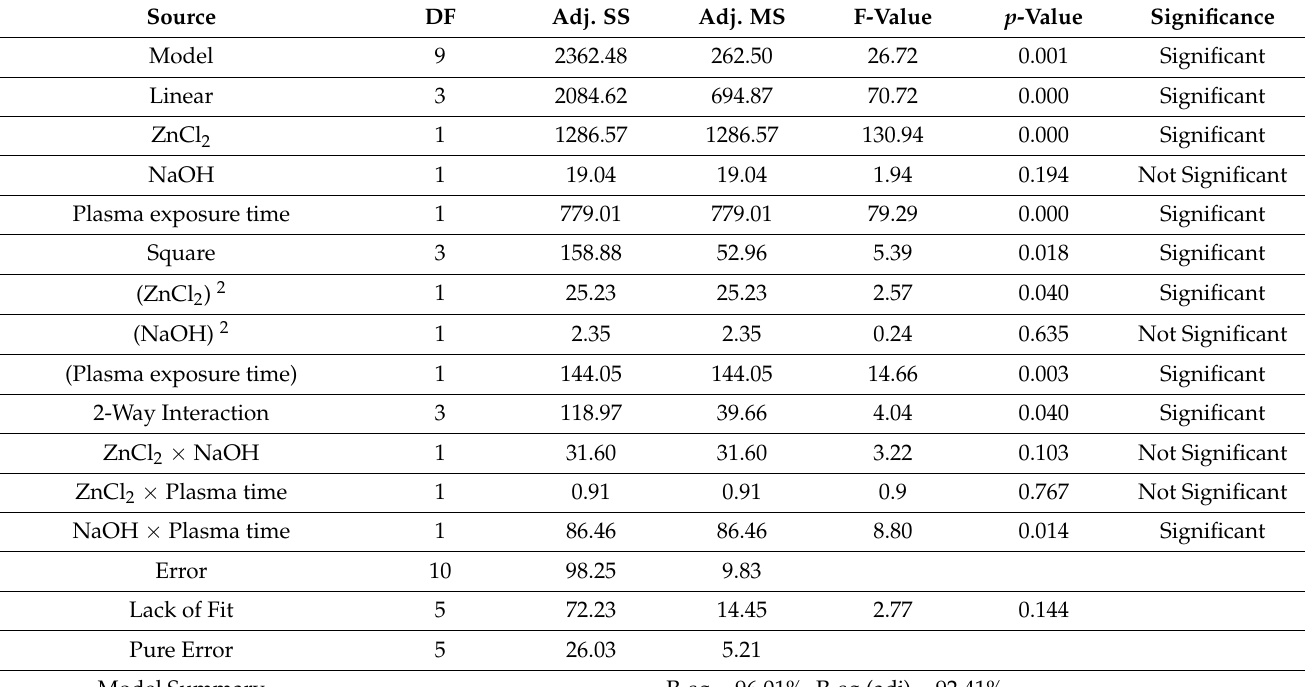
Table 2. Summary of ANOVA analysis used to study self-cleaning of the coated